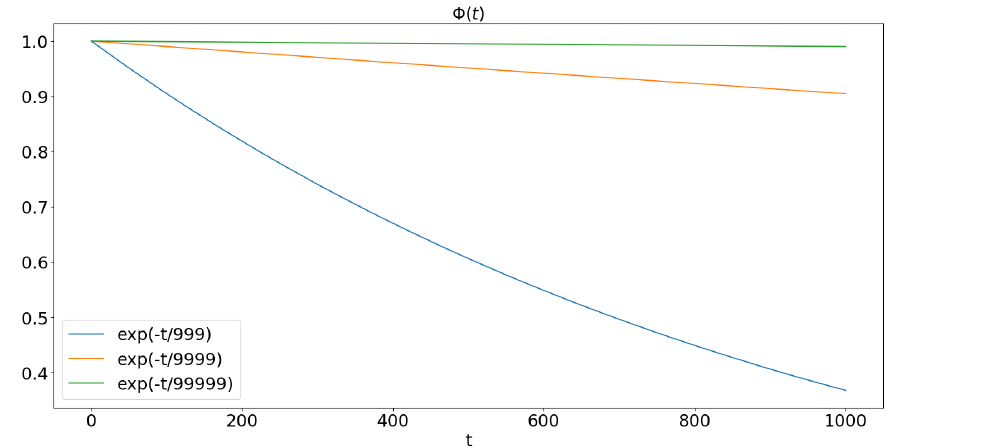
Figure 3. One of the parameters of our simulation Was attenuation. The propagating waves were attenuated exponentially with the function e − i a , where i is the time and a is the attenuation parameter. Here, we plotted the function with 999; 9999 and 99,999 attenuation parameters. Since the dependence of attenuation on this parameter is exponential, it can heavily affect the accuracy of a neural network.